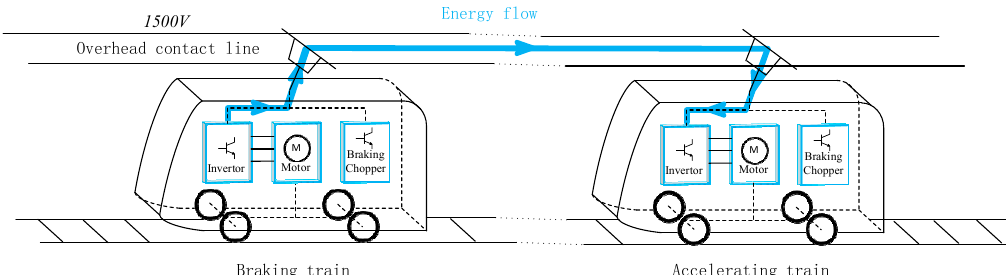
Figure 1. Energy flow between trains.